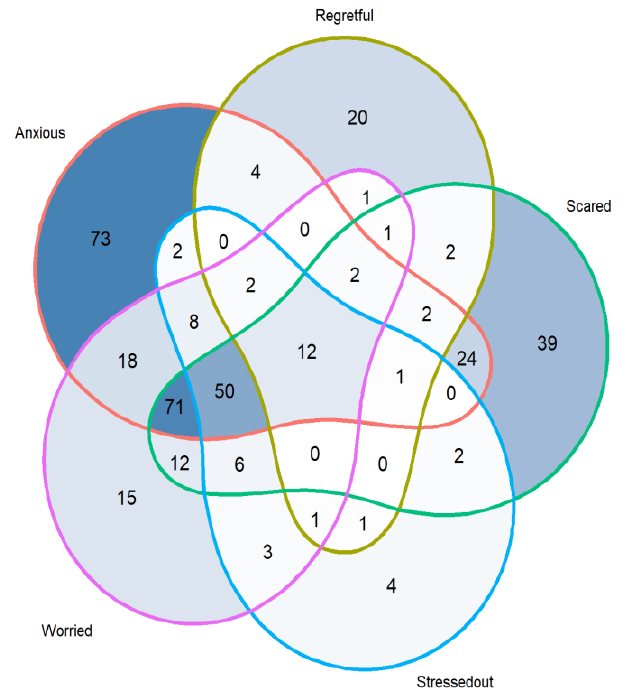
Figure 2. Negative emotions expressed (i.e., strongly agree or agree) by 374 of the 993 participants in the BREATHE study recruited between October 2021 and March 2022.